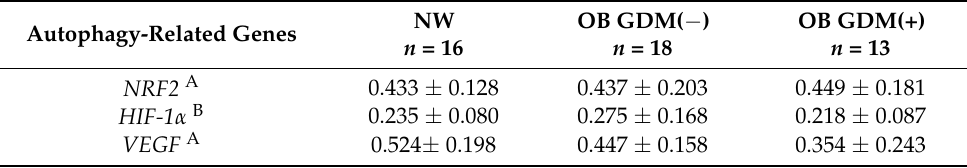
Table 6. Expression levels of autophagy-related genes in placental